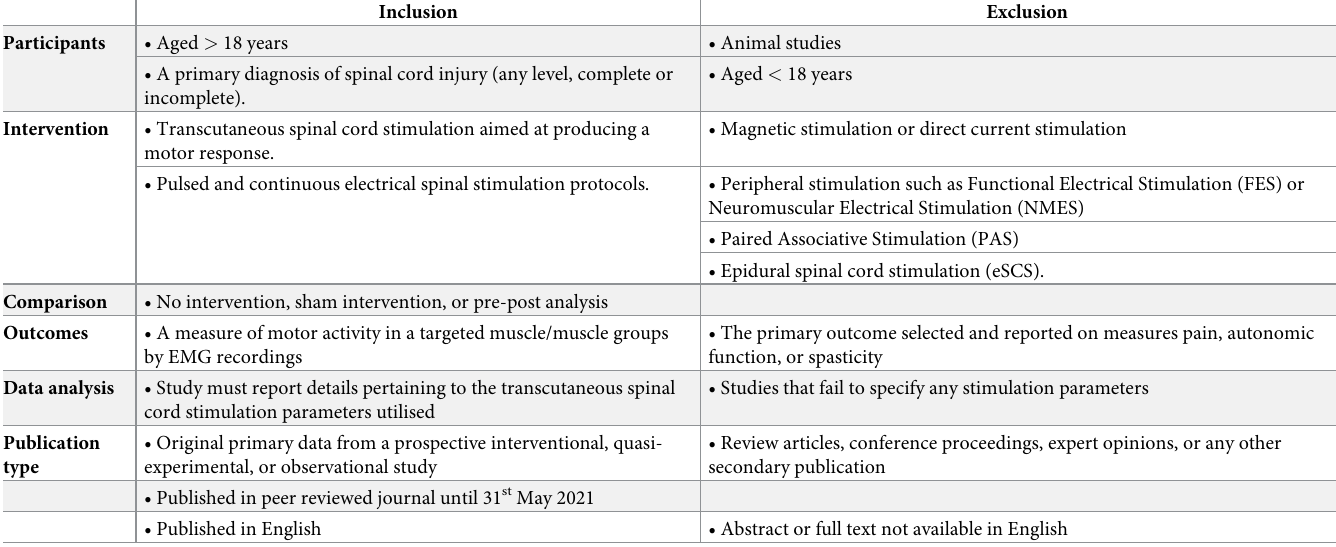
Table 1. The eligibility criteria to determine suitable studies for inclusion in the full-text systematic